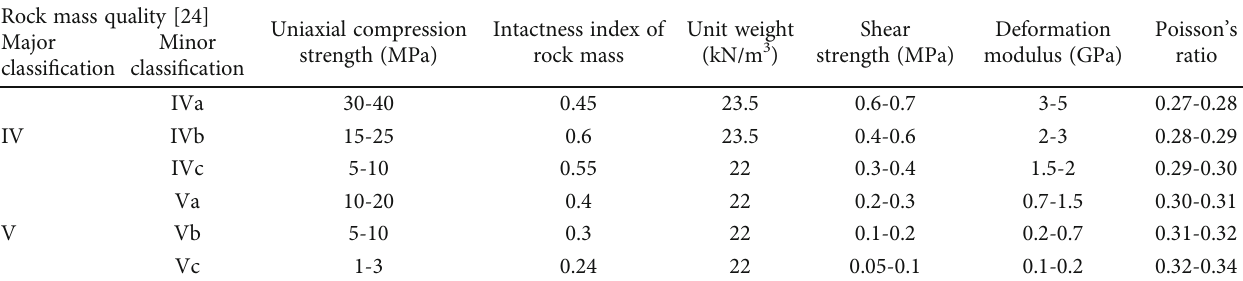
Figure 1: Overview of the downstream TBM (Tunnel Boring Machine) section of Xianglushan Tunnel. (a) Planning curve of the Central Yunnan Water Diversion Project and location of Xianglushan Tunnel; (b) working condition of the downstream TBM section of Xianglushan Tunnel. Table 1: Mechanical parameters of Class IV and V rock mass in Xianglushan Tunnel.